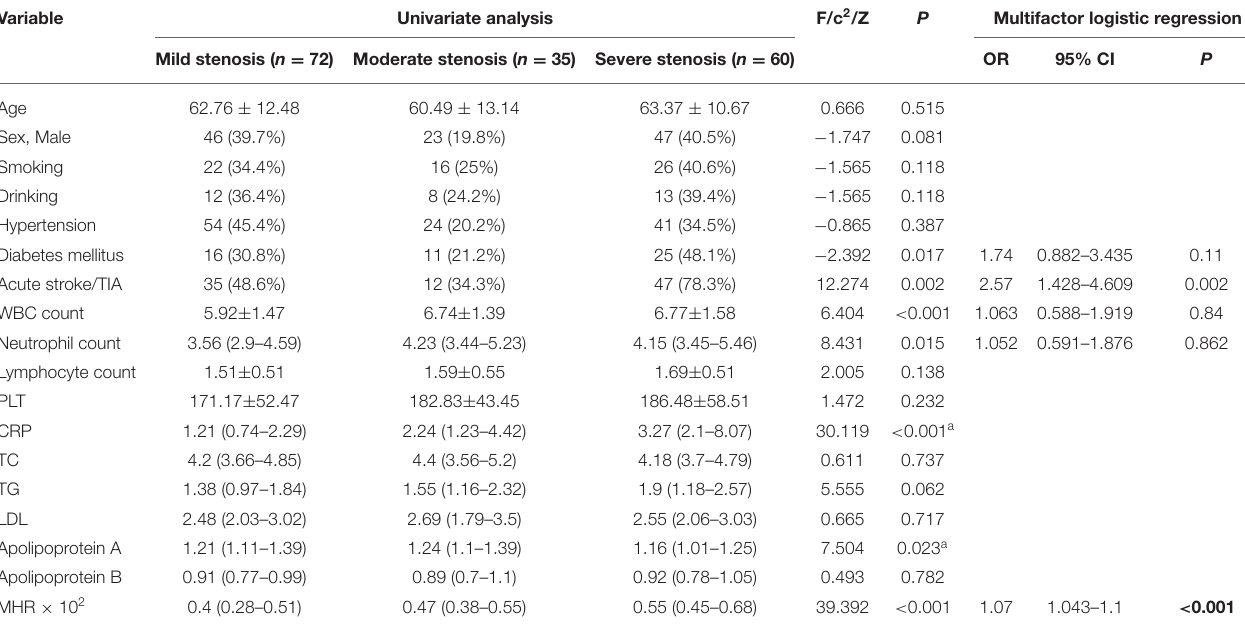
TABLE 2 | Associations of factors with the severity of intracranial atherosclerotic stenosis. Variable Univariate analysis F/c 2 /Z P Multifactor logistic